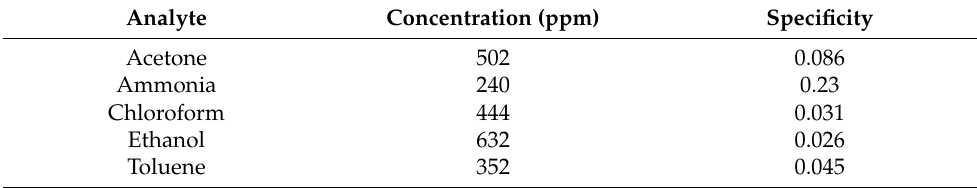
Figure 10. Response of the WS 2 nanoflowers to 1.5 µL of each analyte at 25% RH. Table 2. Specificity values of the sensor to each chemical vapor.